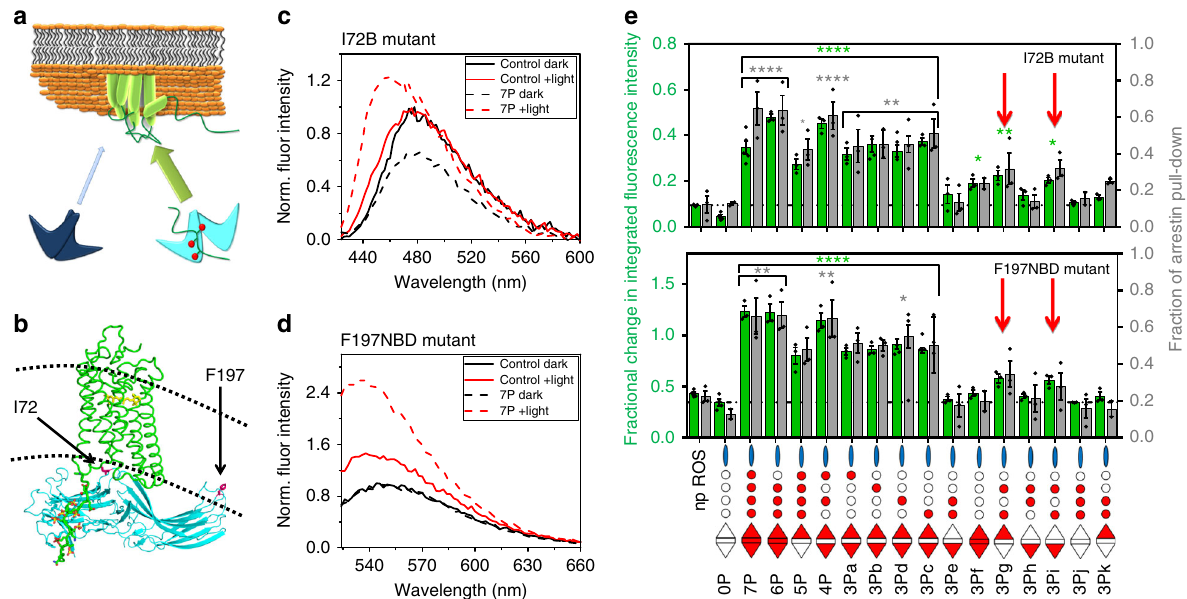
Fig. 4 Ternary complex formation depends on peptide phosphorylation pattern. a Schematic representation of phosphopeptide-induced arrestin-1 activation and recruitment to nonphosphorylated light-activated rhodopsin in the native membrane. b Model of a complex of arrestin-1 bound to active phosphorylated rhodopsin (own work). Locations of the introduced fl uorescent probes on the fi nger loop (I72) and C-edge (F197) are indicated, as is the membrane bilayer (dashed lines). c Steady-state fl uorescence spectra of arrestin-1 mutant I72B in the presence of nonphosphorylated rhodopsin, measured in the dark-state (black spectra) and after light-activation (red spectra), in the absence (solid spectra) or presence (dashed spectra) of fully phosphorylated peptide 7P. d Steady-state fl uorescence spectra of arrestin-1 mutant F197NBD, as described in ( c ). e Quanti fi cation of ternary complex formation using arrestin-1 mutants I72B and F197NBD as measured by fl uorescence (green bars, left axes) and centrifugal pull-down analysis (gray bars, right axes). The results of a statistical analysis (ANOVA) of each peptide versus “ np ROS ” are indicated by green ( fl uorescence) and gray (pull-down) stars above each column (* P ≤ 0.05, ** P ≤ 0.01 and **** P ≤ 0.0001). The red arrows indicate tri-phosphorylated peptides which lack one of the key sites pT340 or pS343 but include the weak recruiter (secondary) sites pT335 and pS338. Data represent the average± s.e.m. from three independent